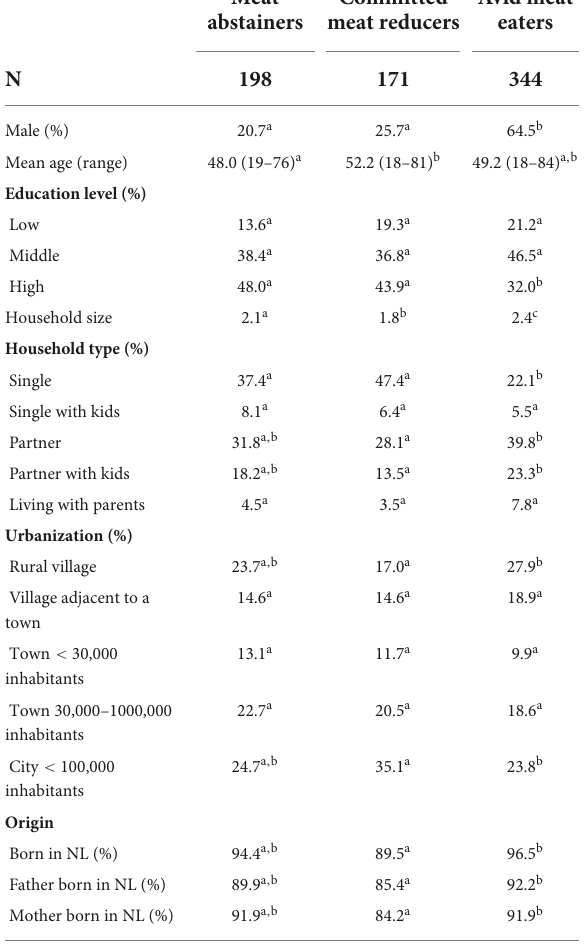
TABLE 1 Socio-demographic characteristics per dietary consumer